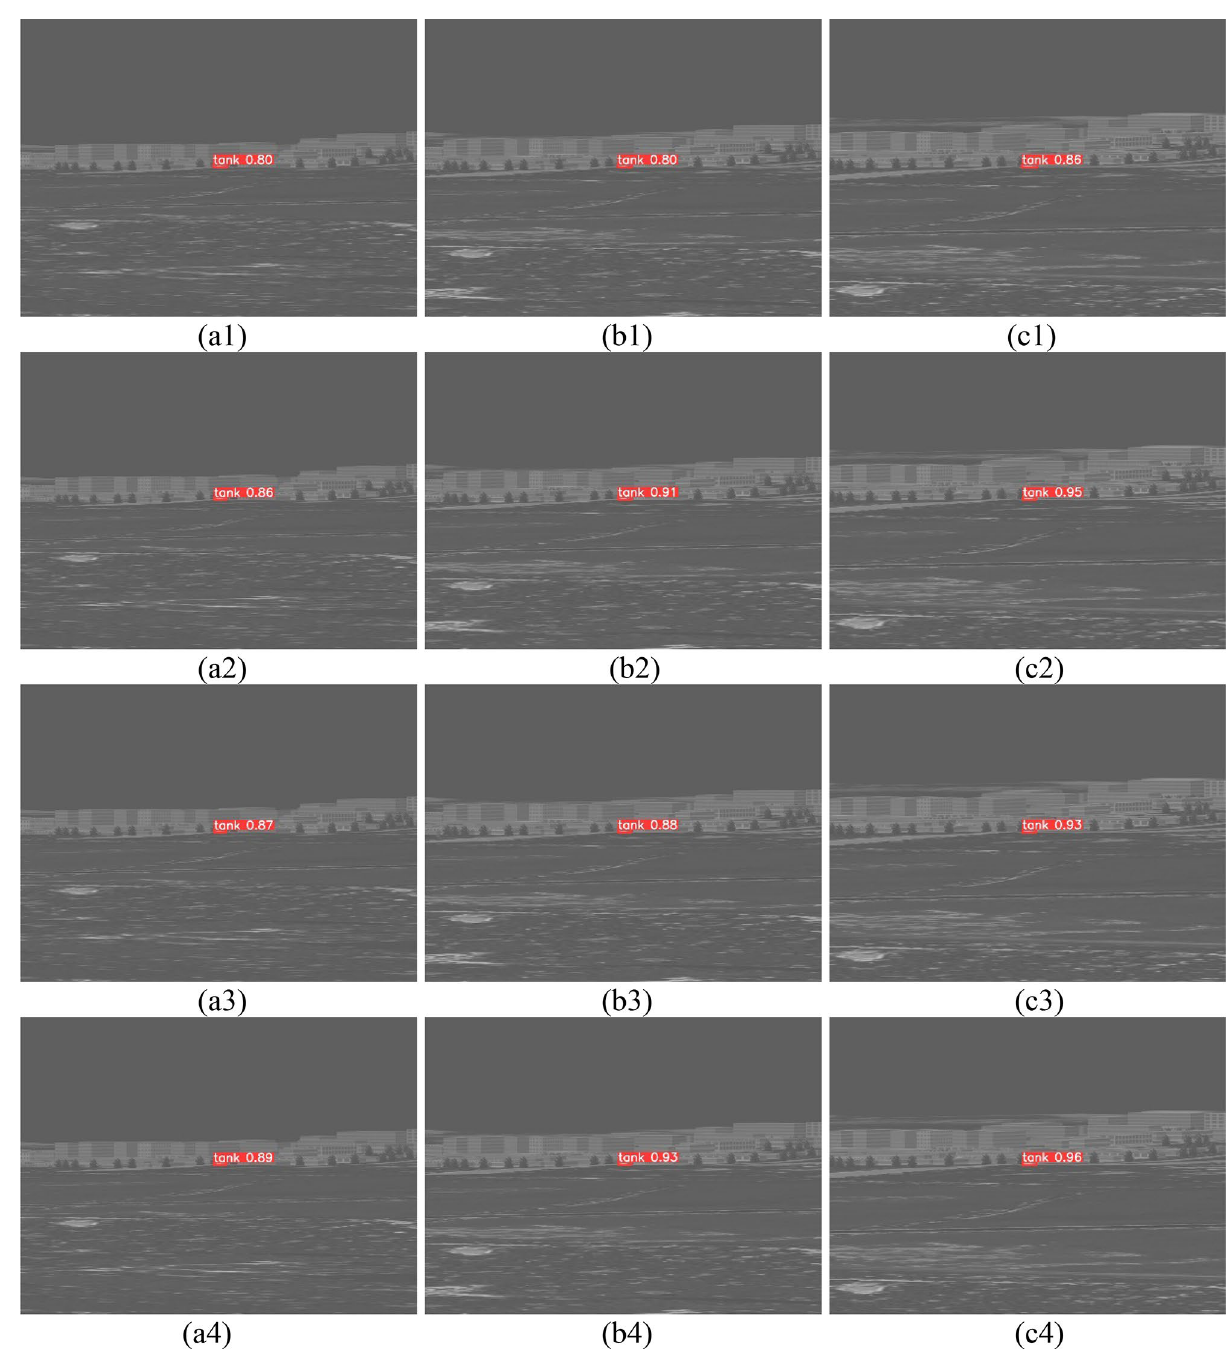
Figure 12. Comparison of small target detection results.